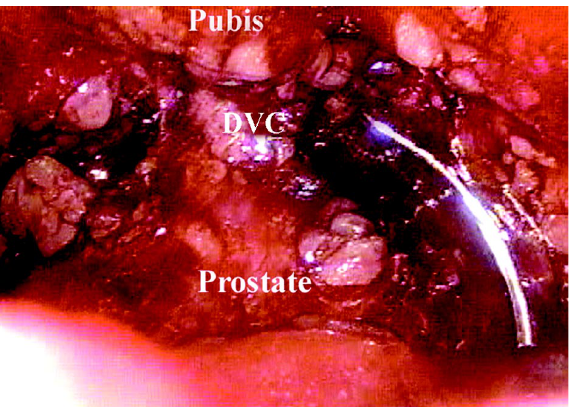
Figure 4 – Vascular control of the dorsal vein complex (DVC).